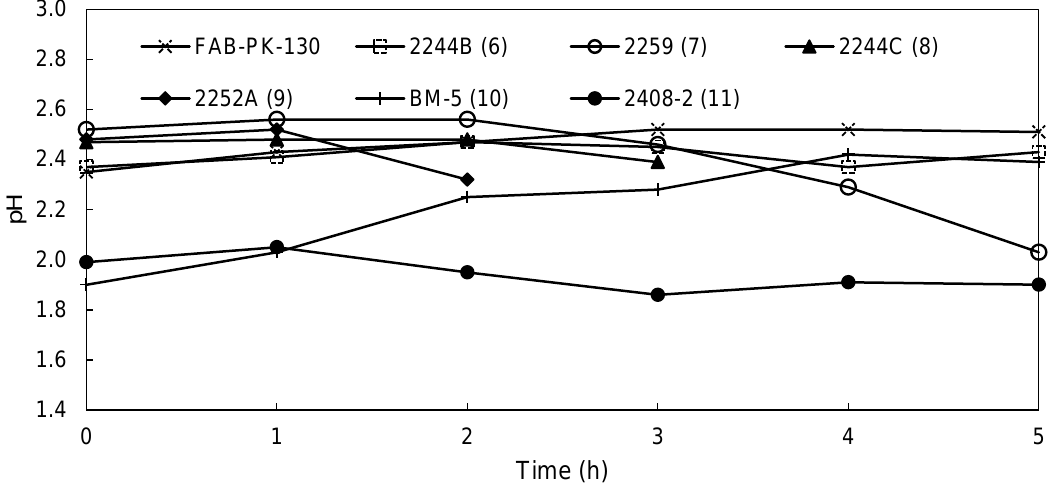
Figure 5. Change in the catholyte pH for membranes FAB-PK-130, 2244B (6), 2259 (7), 2244C (8), 2252 A (9), BM-5 (10), and 2408-2 (11) during EW.